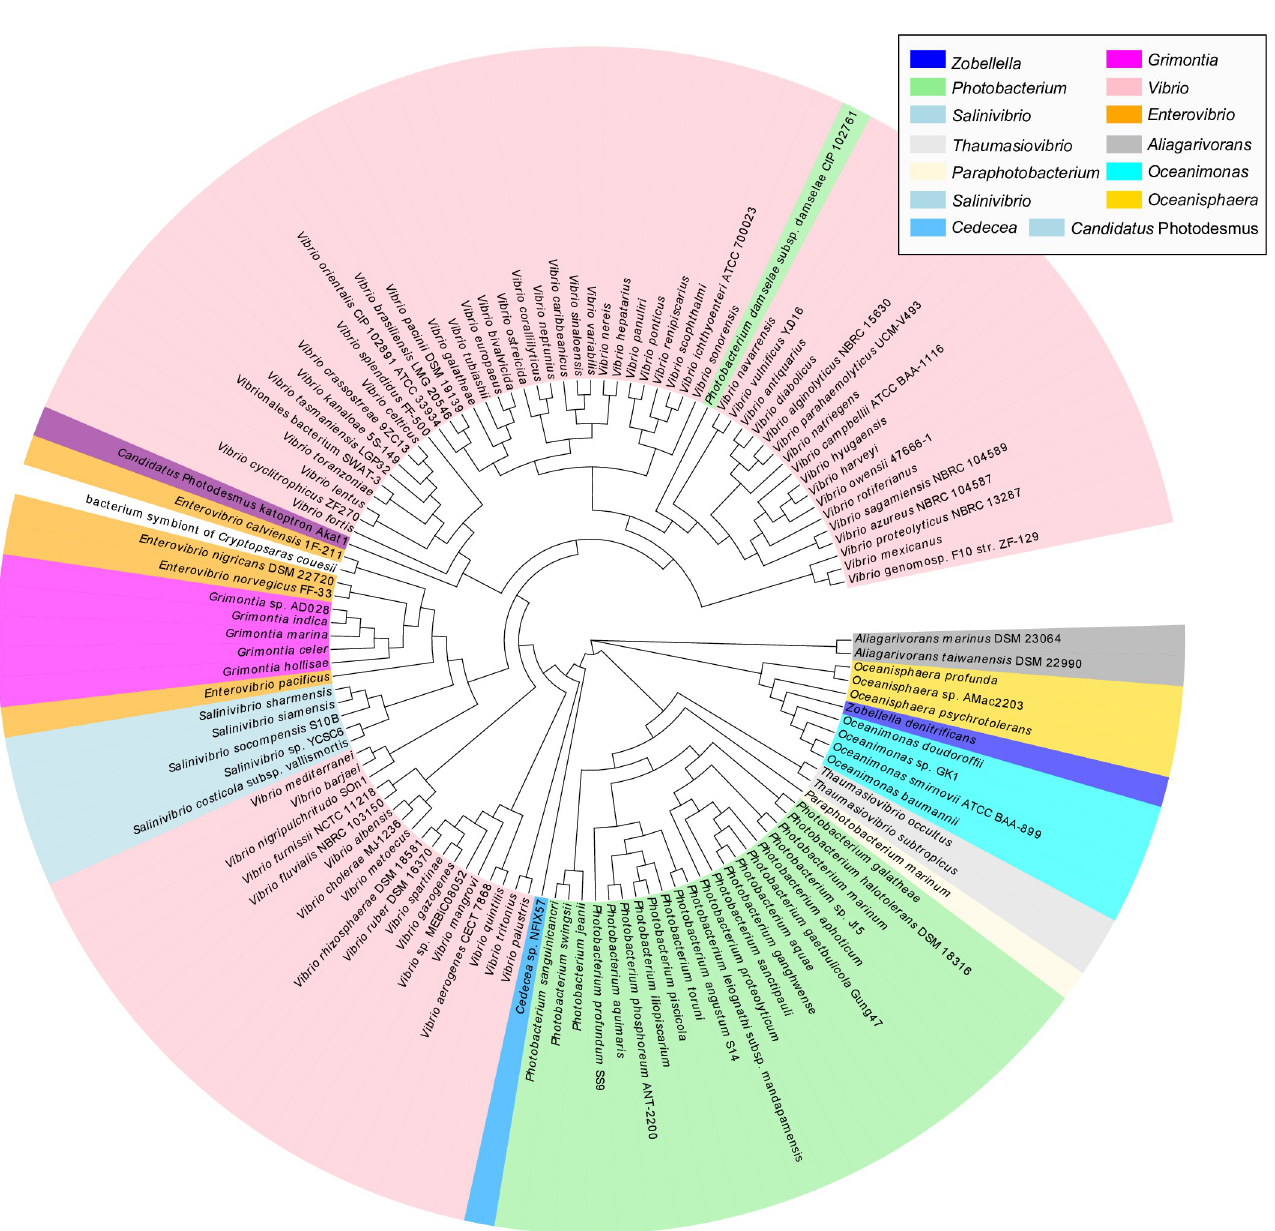
Fig 5. Concatenated protein tree built from four genes of the PHB gene cluster. The same color indicates the same genus rank. Zobellella denitrificans is indicated by blue color on the right side.